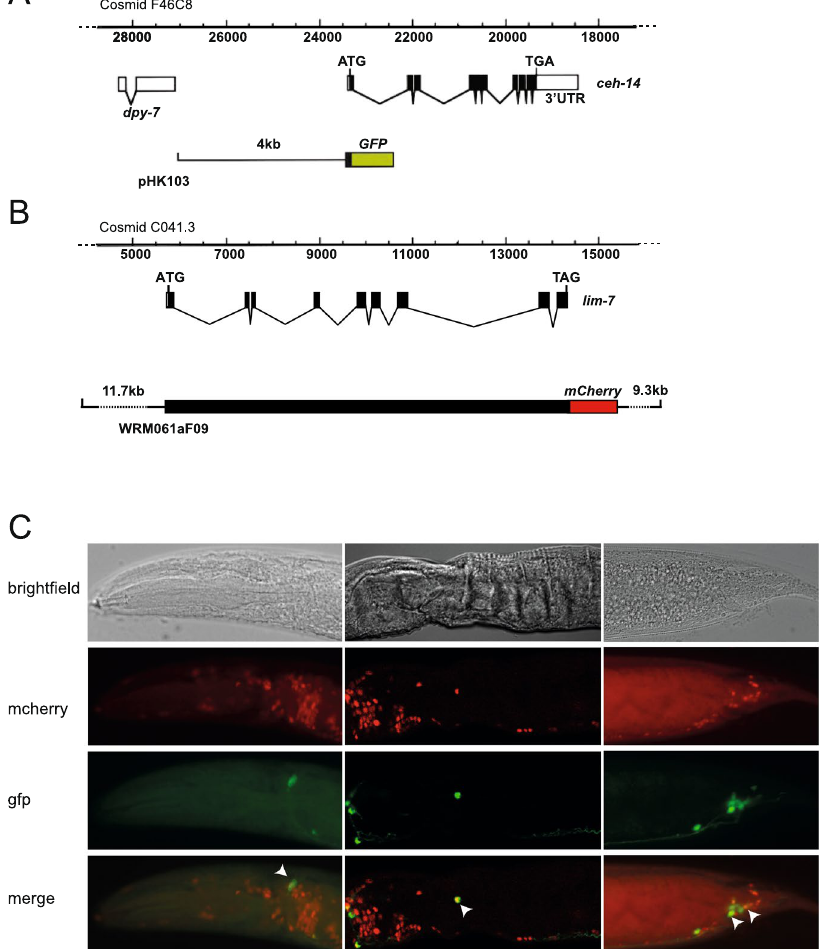
Figure 6. CEH-14 and LIM-7 are co-expressed in several C. elegans neurons. ( A ) The ceh-14 locus within cosmid F46C8 is shown with exons indicated by black boxes and introns by lines. The ceh-14::GFP reporter construct in plasmid pHK103 is shown underneath. The diagram was modified from 27 . ( B ) The lim-7 locus within cosmid C04F1 is shown with exons indicated by black boxes and introns by lines. The structure of the lim-7::mCherry reporter construct created by recombineering fosmid WRM061aF09 is shown underneath. (C) Fluorescence micrographs depict expression of the ceh-14::GFP ( chIs513 ) and lim-7::mcherry ( stIs10289 ) reporters in the head (left panels) and tail (right panels) of adult hermaphrodites of strain HRN073. The corresponding brightfield image is shown above and a merged image is shown below. Representative cells in which both gfp and mcherry fluorescence was observed are indicated by